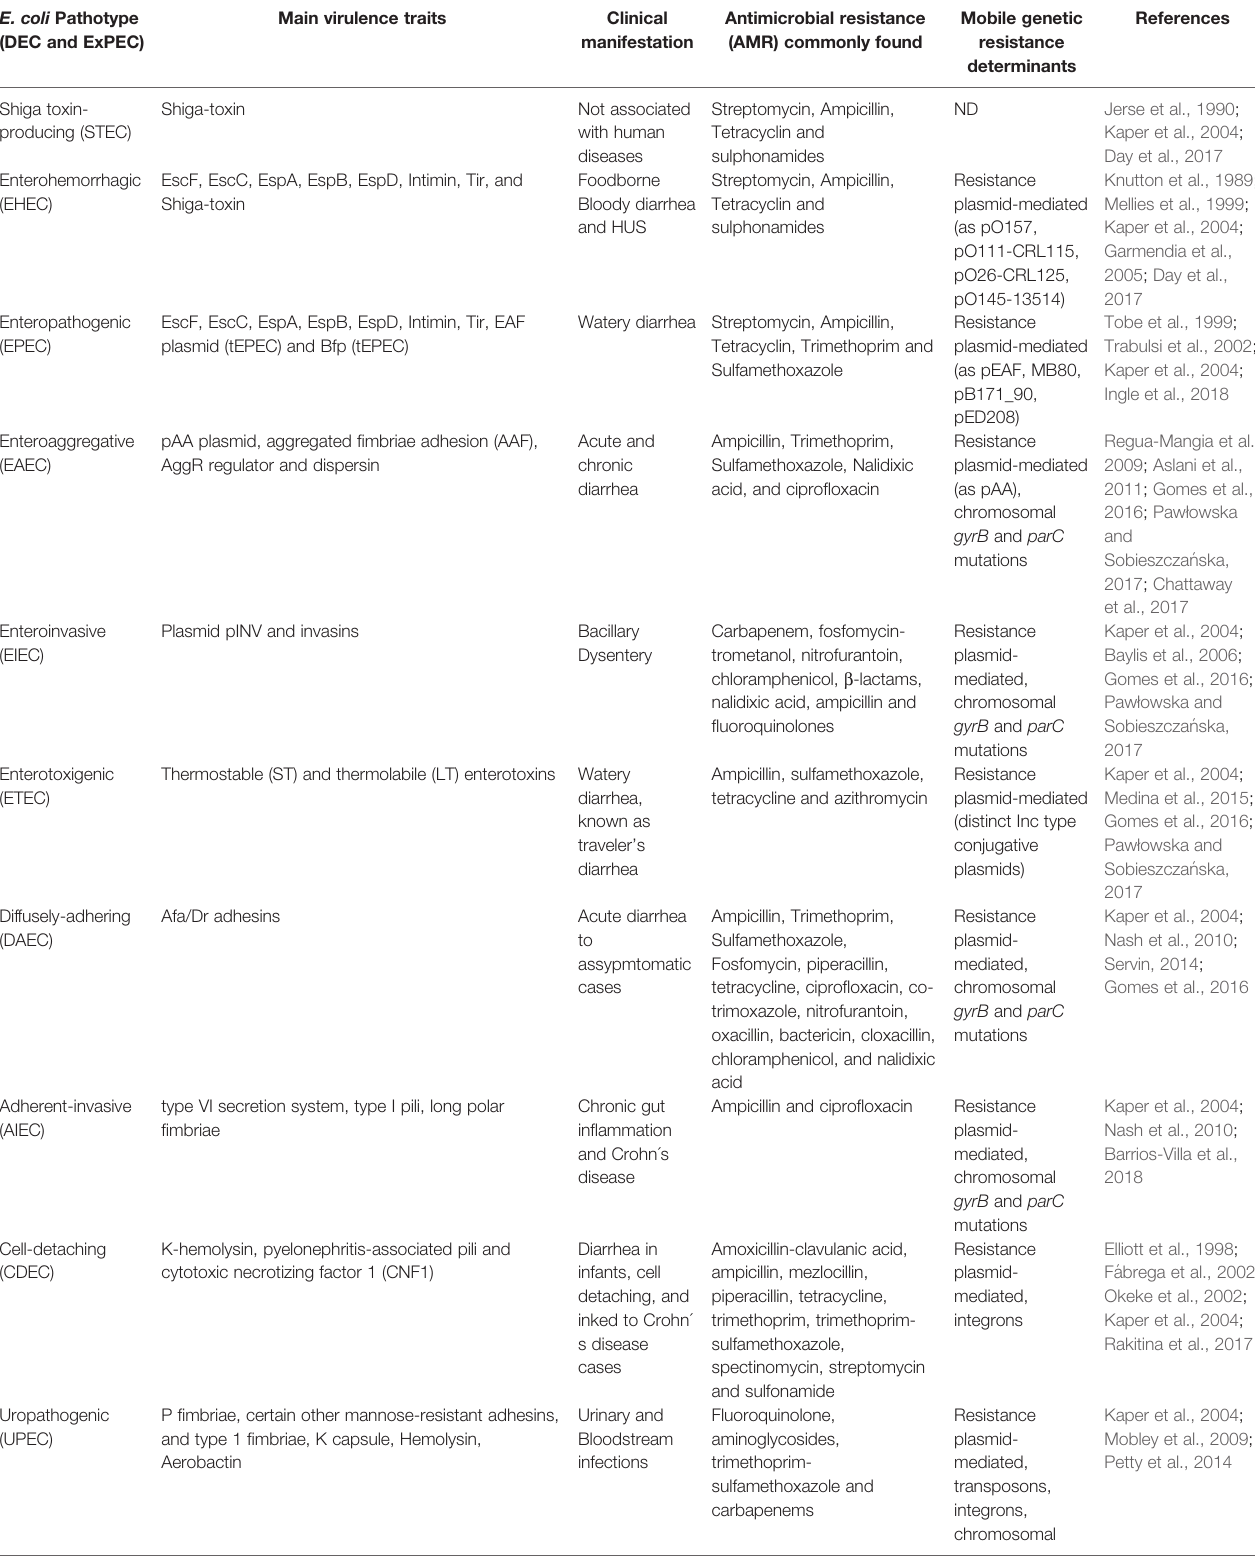
TABLE 1 | Classic E. coli pathotypes main features: extraintestinal (ExPEC) and diarrheagenic